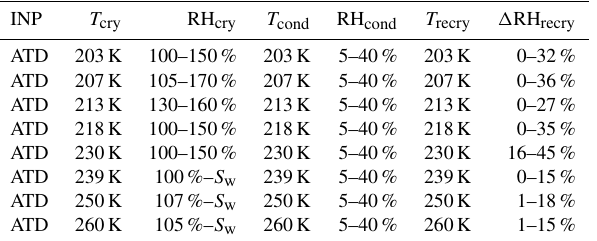
Table 8. Particles deposited on hydrophobic substrates by Knopf and Koop (2006). T cry – crystallization temperature; RH cry – crys- tallization RH with respect to ice; T cond – conditioning temperature; RH cond – conditioning RH with respect to ice; T recry – recrystal- lization temperature; (cid:49) RH recry – difference between crystallization and recrystallization RH with respect to ice; S w – water